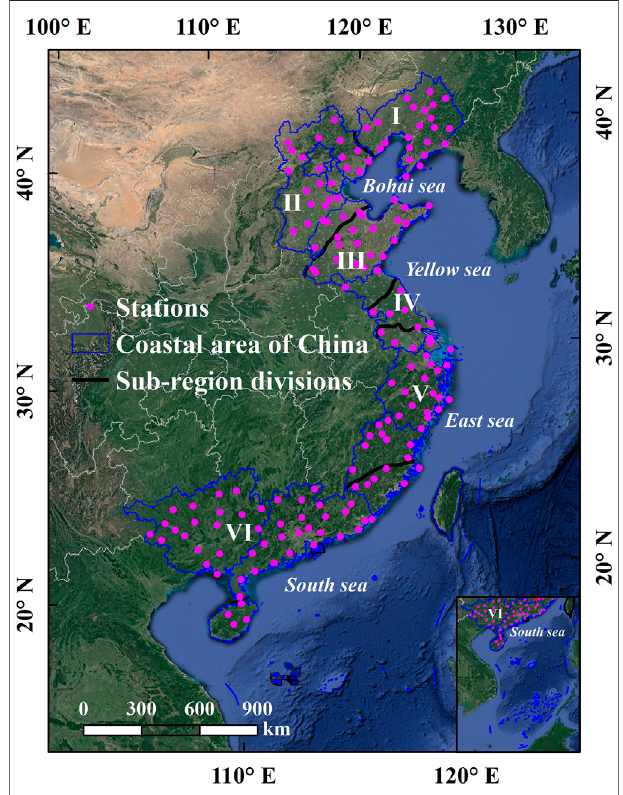
FIGURE 1 | Location map of the coastal area of China and the meteorological